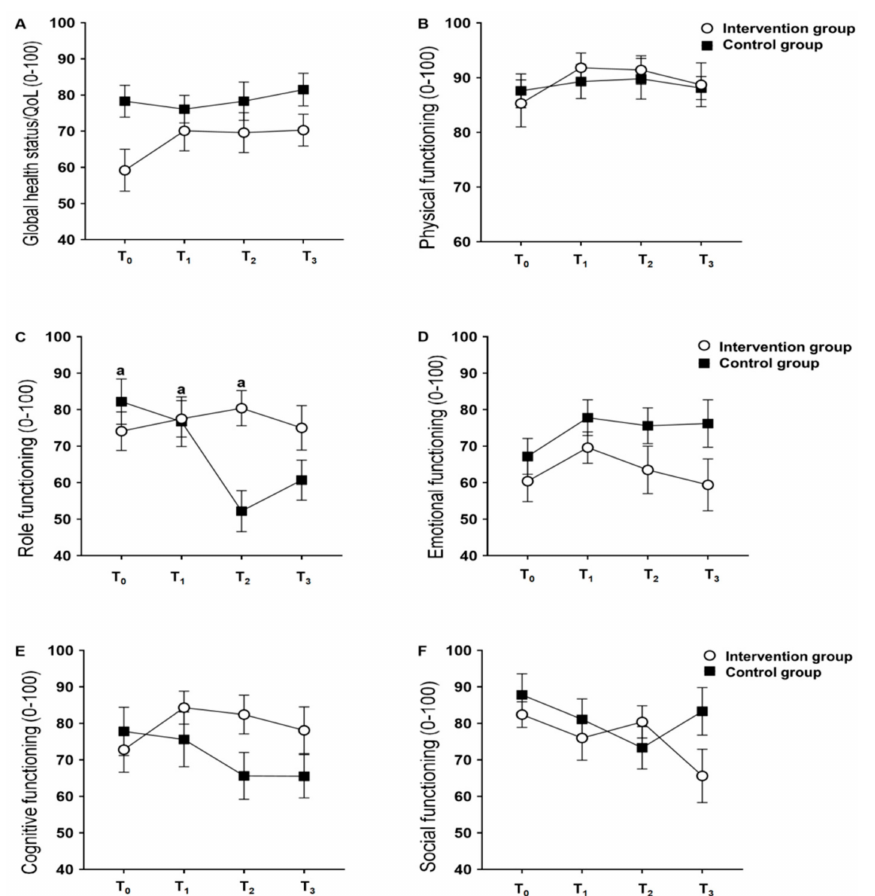
Figure 3. Comparison of global health/QoL and functional scales by the EORTC QLQ-C30 between the nutritional intervention and control groups throughout the study. ( A ) Global health status/QoL; ( B ) Physical functioning; ( C ) Role functioning; ( D ) Emotional functioning; ( E ) Cognitive functioning; ( F ) Social functioning. Abbreviations: Data presented as mean and standard deviation. T 0 , study baseline, pre-chemotherapy moment; T 1 , regarding the end of the first chemotherapy cycle; T 2 , regarding the end of the second chemotherapy cycle; T 3 , regarding the end of the third cycle of chemotherapy. a represents a statistical difference from T2 in the control group ( p =